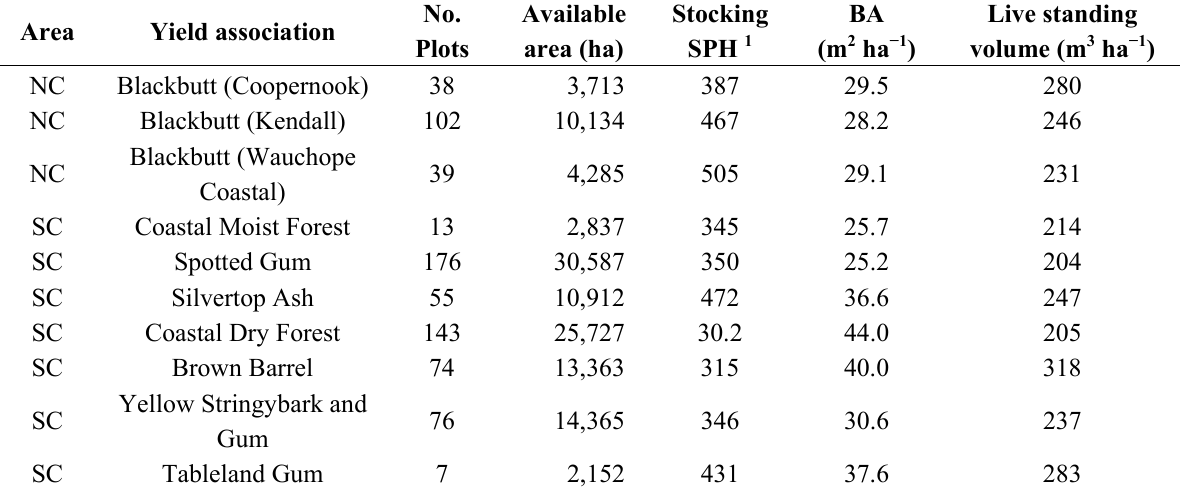
Table 1. Stand details by study area/yield association group for north coast (NC) and south coast (SC)